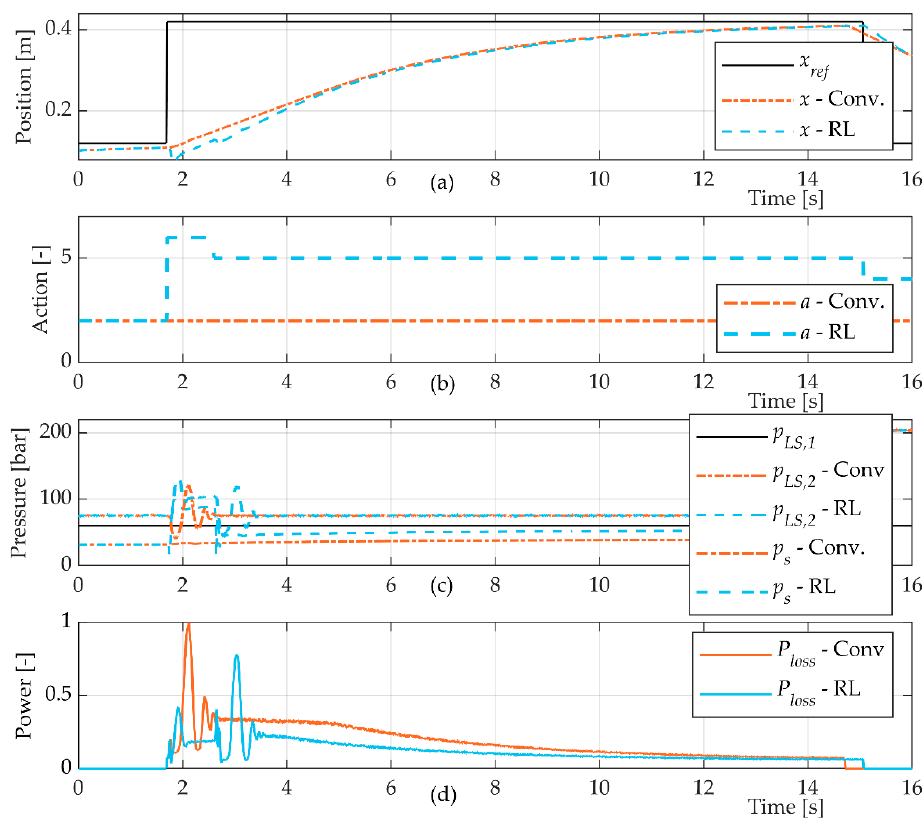
Figure 7. Simulation result, 40 kg load and p LS ,1 = 60 bar. ( a ) Position; ( b ) action; ( c ) system and load-sensing pressures; ( d ) power loss.